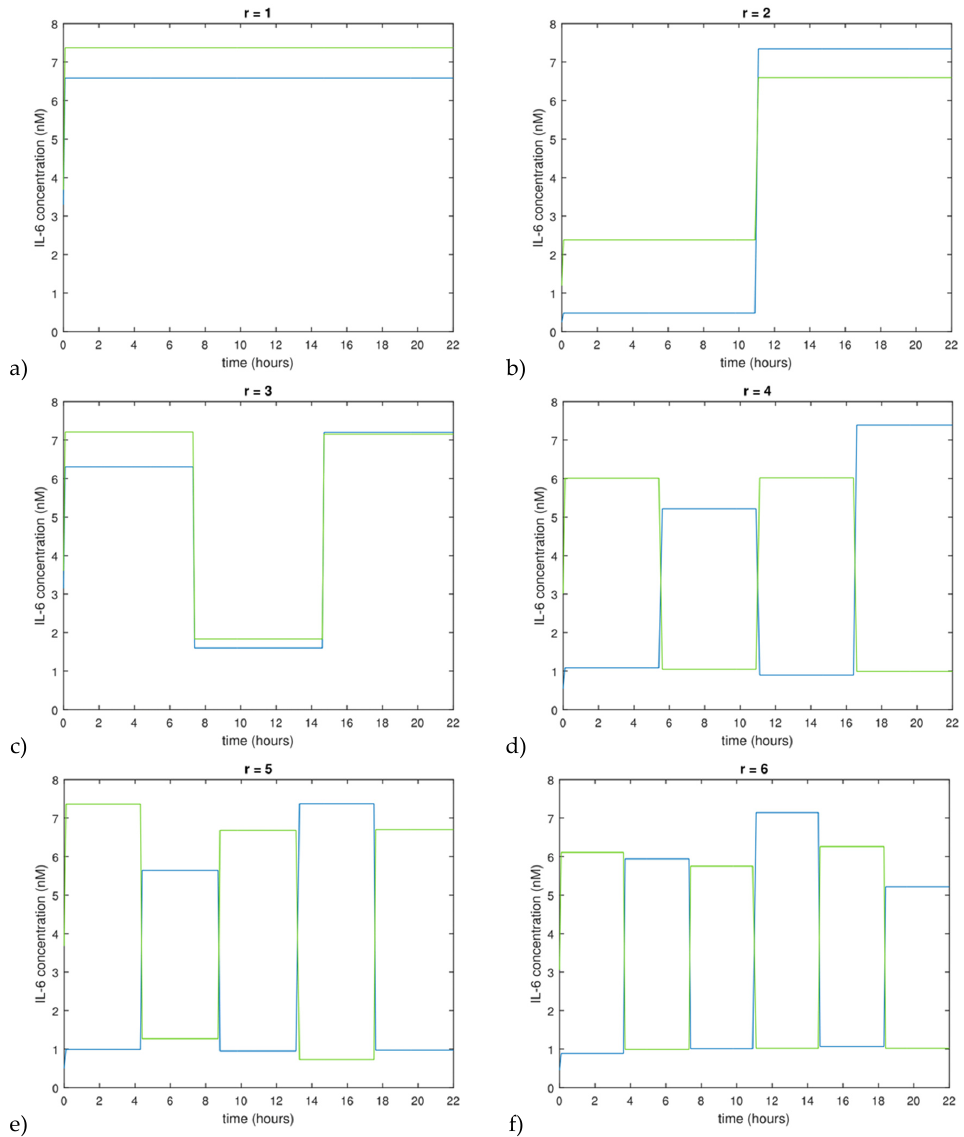
Figure 2. Optimal input functions for values of r from 1 to 6. Blue indicates input functions identified as optimal from the local sensitivity method, green indicates input functions identified as optimal from the Morris method. ( a ) r = 1 ( b ) r = 2 ( c ) r = 3 ( d ) r = 4 (e ) r = 5 ( f ) r = 6. Table 2. Optimal input functions for values of r from 1 to 6 via the Morris method